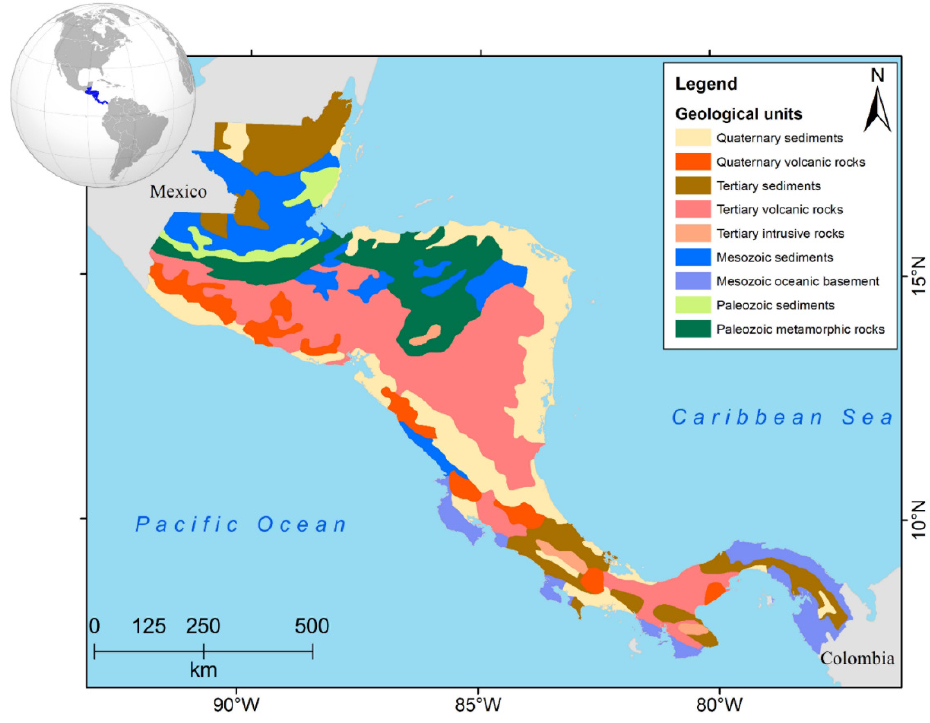
Figure 2. Geological units from Central America (modified from [42]).